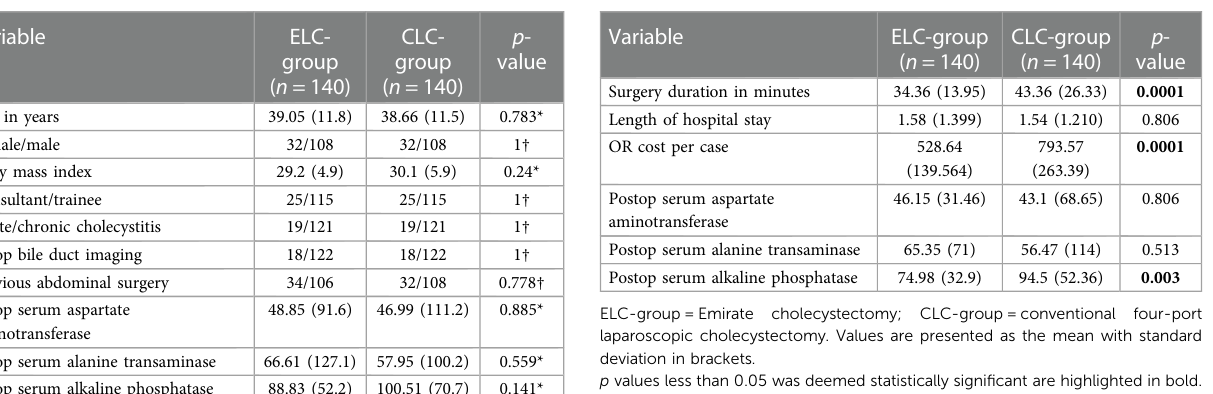
TABLE 2 Post-operative data for each study